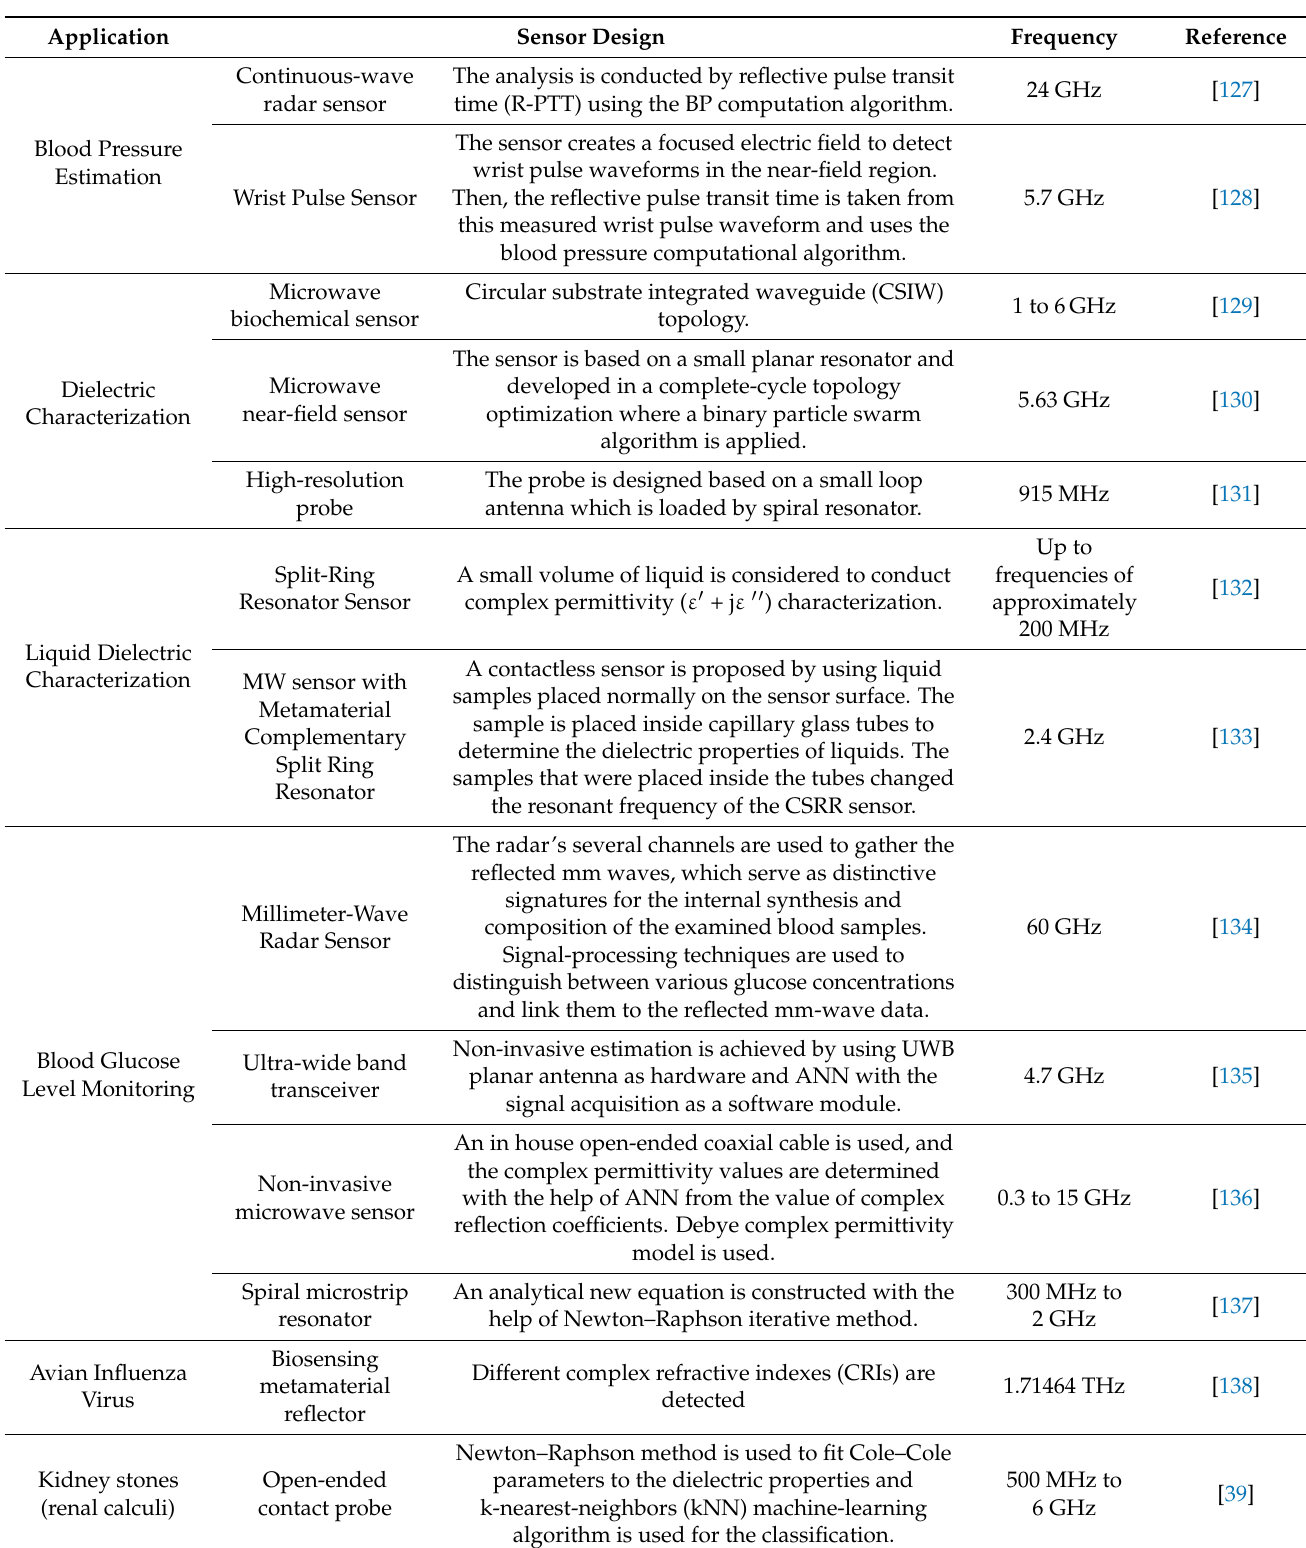
Table 1. Overview of microwave sensor design and applications in